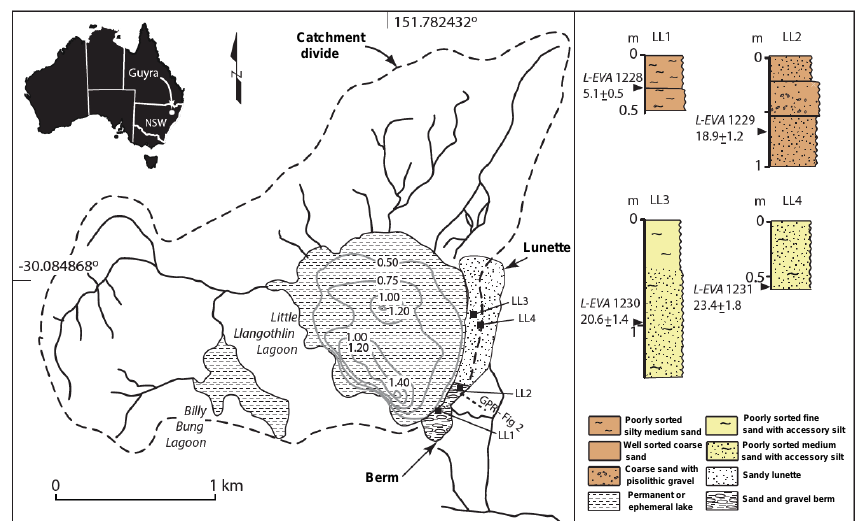
Figure 1. Geomorphology and sediments at Little Llangothlin Lagoon (30 ◦ 5 (cid:48) 9 (cid:48)(cid:48) S, 151 ◦ 46 (cid:48) 53 (cid:48)(cid:48) E), 18km NE of Guyra, NSW, showing the locations of GPR transects, sediment cores (right), and the position of OSL